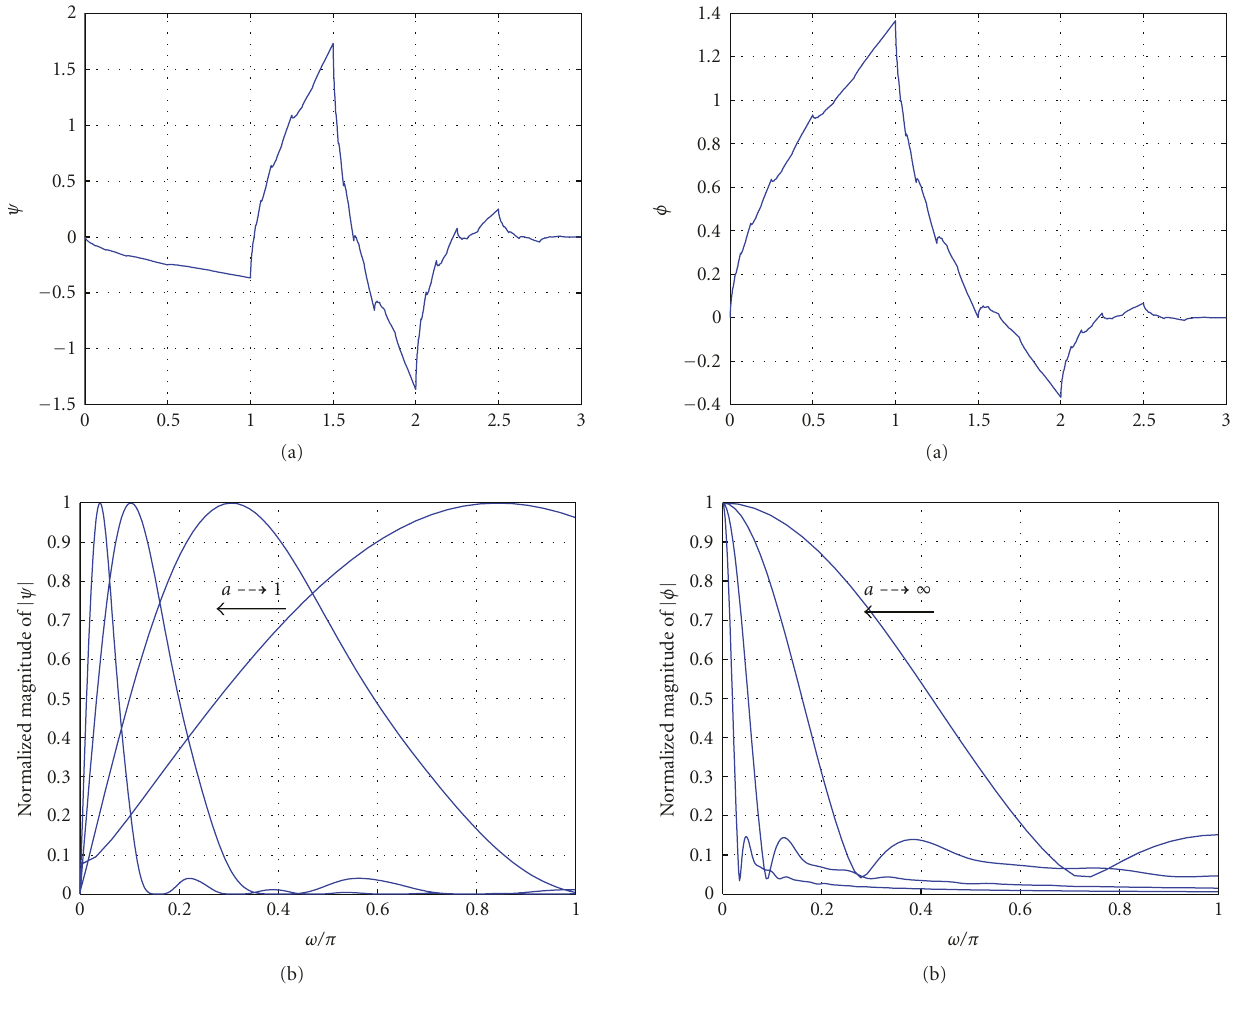
Figure 13: (a) Scaling function of db2 and (b) its Fourier trans- forms at various